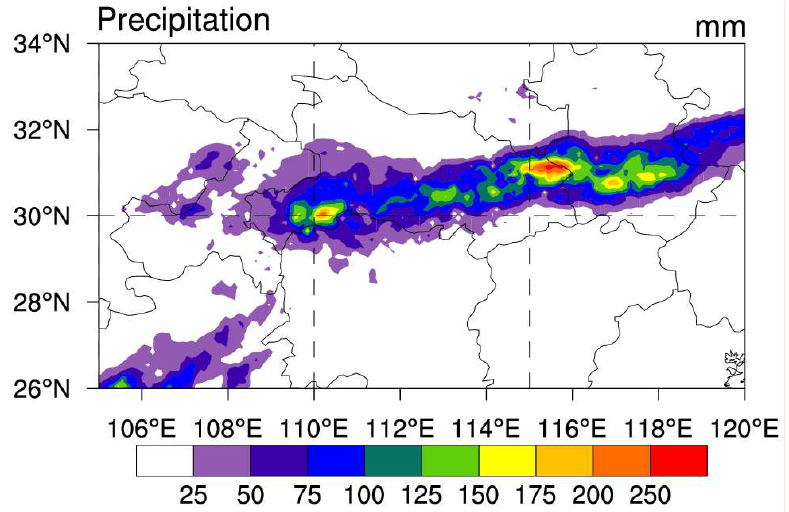
Figure 3. The 24h accumulated observed precipitation initialized at 00:00 UTC on 29 June 2009. Figure 3. The 24 h accumulated observed precipitation initialized at 00:00 UTC on 29 June